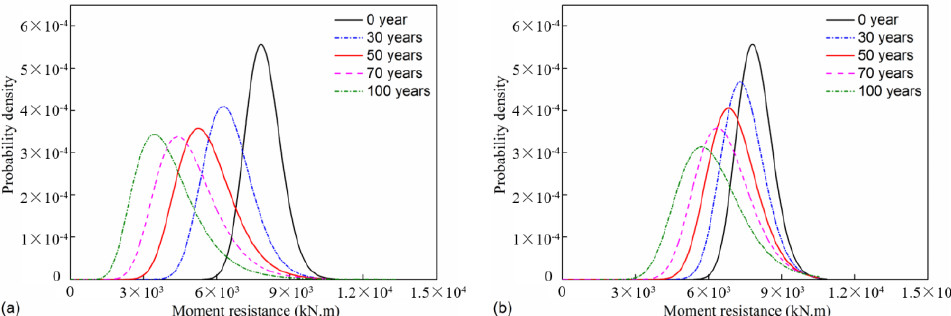
Figure 11. Moment resistance distribution: ( a ) splash and tidal zone; ( b ) atmospheric zone.